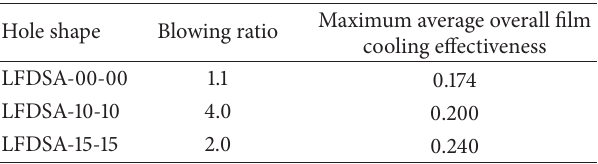
Table 1: Average overall film cooling effectiveness at different blow- ing ratios.